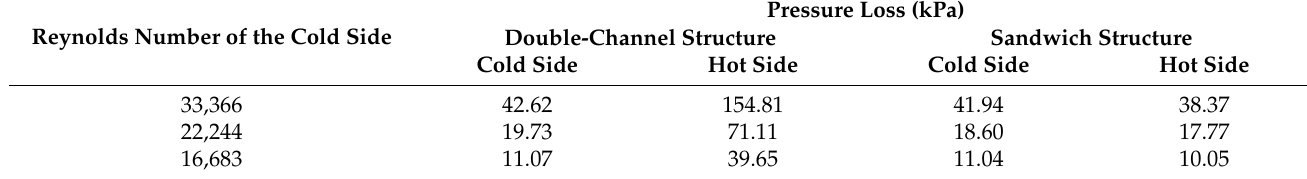
Table 6. Pressure loss comparisons between sandwich-structure and double-channel models.